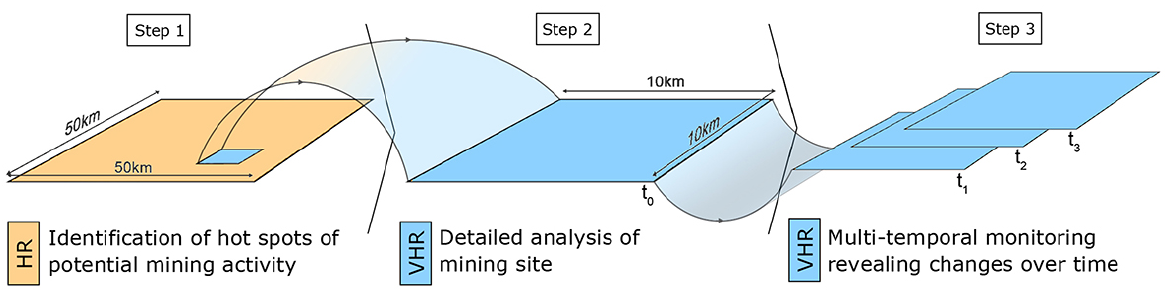
Figure 4. Staggered workflow of the